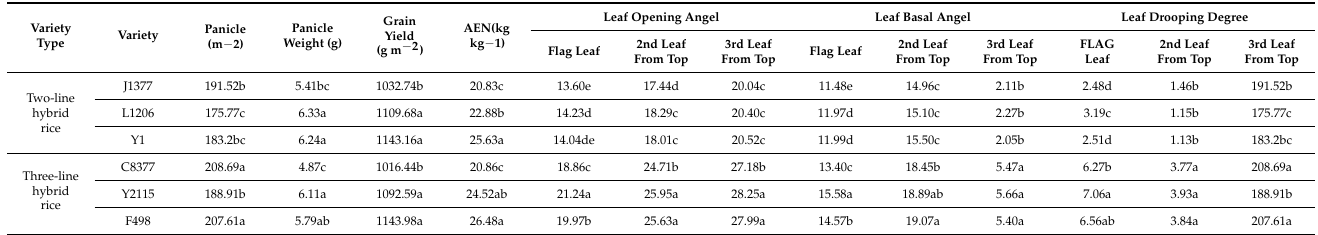
Table 2. Main characteristic parameters of yield and plant type of experimental